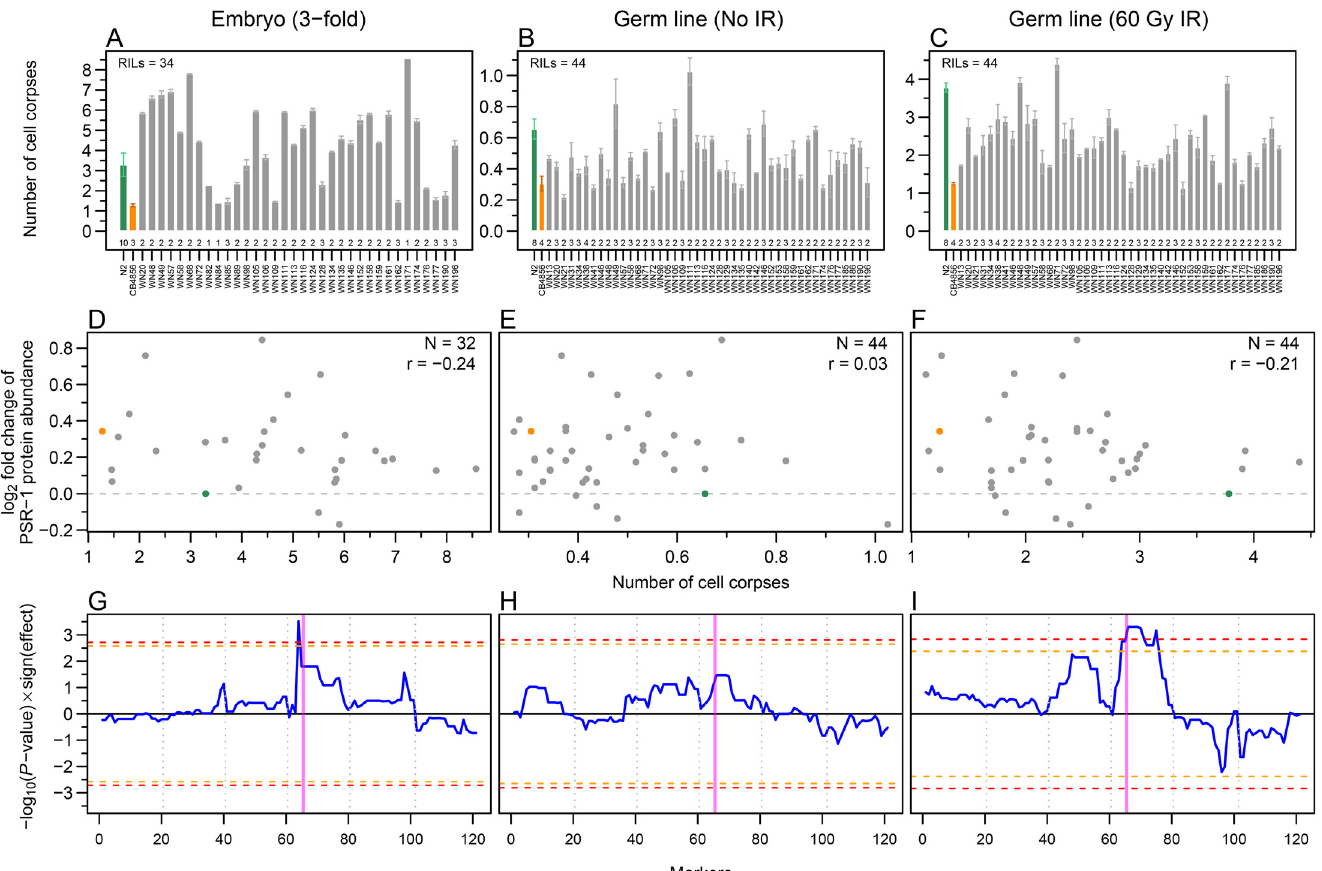
Fig 7. Analysis of variation in embryonic and germ line apoptosis in parental strains and RILs. (A-C) Quantification of apoptotic cell corpse numbers in embryos (A), germ line without ionizing radiation (IR; B), and with 60 Gy IR (C). Error bars represent SEM between numbers of biological replicates indicated at the bottom of each bar. (D-F) Natural variation in apoptosis levels of parental strains and RILs does not correlate with the PSR-1 protein abundance (relative to N2). Scatter plots (CB4856 in orange and N2 in green) of PSR-1 protein abundance and apoptotic levels in embryos (D), germ line without IR (E), and with 60 Gy IR (F). Pearson correlation coefficient is denoted by r. (G-I) Embryonic and IR-induced apoptosis shows a significant QTL on chromosome IV. QTL profiles of apoptotic phenotype in embryos (G), adult germ line without IR (H) and with 60 Gy IR (I). Blue curves show the significance of the QTLs multiplied by the sign of the effect of the N2 allele (positive values of blue curve indicate higher apoptosis level when the N2 allele is present, whereas negative values indicate higher apoptosis level when the CB4856 allele is present). Horizontal orange and red dashed lines show 0.1 and 0.05 FDR thresholds respectively. Vertical dotted grey lines separate chromosomes I to V and X from left to right. Vertical magenta band indicates the position of psr-1 gene in the